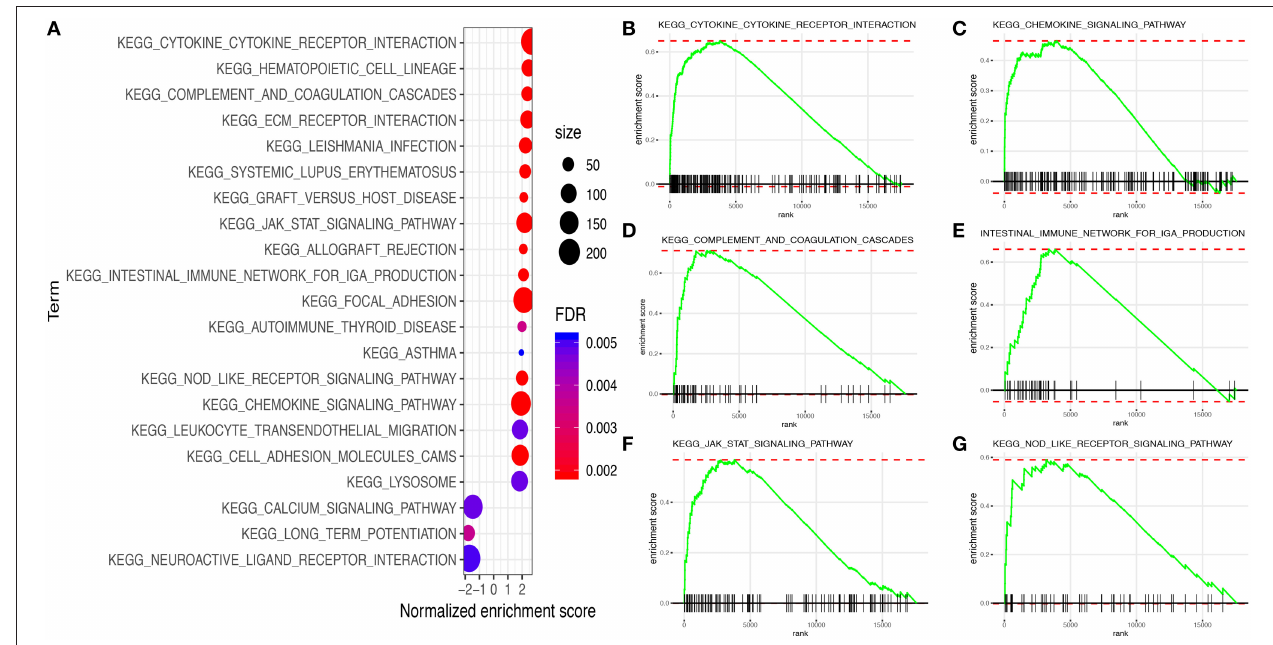
FIGURE 8 | Gene set enrichment analysis (GSEA) between high and low immune risk groups. (A) 22 Kyoto Encyclopedia of Genes and Genomes (KEGG) pathway-related gene sets. (B) Cytokine–cytokine receptor interaction. (C) Chemokine signaling pathway. (D) Complement and coagulation cascades. (E) Intestinal immune network for IgA production. (F) JAK–STAT signaling pathway. (G) NOD-like receptor signaling